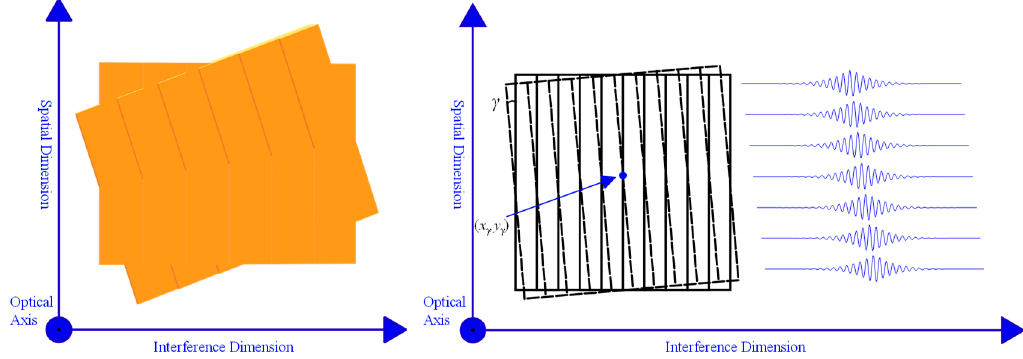
Figure 5. Rotation error structure.